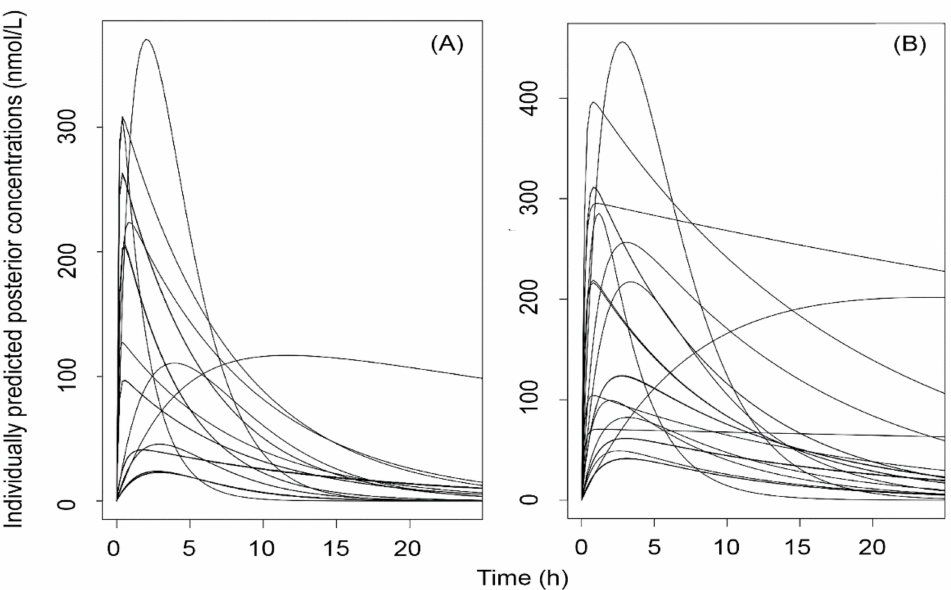
Figure 6. Individual 24 h estimated posterior time-concentration curves obtained by constructing nonparametric population pharmacokinetic models of ( A ) ATR + ATRL and of ( B ) ATR + MET using the software package Pmetrics TM